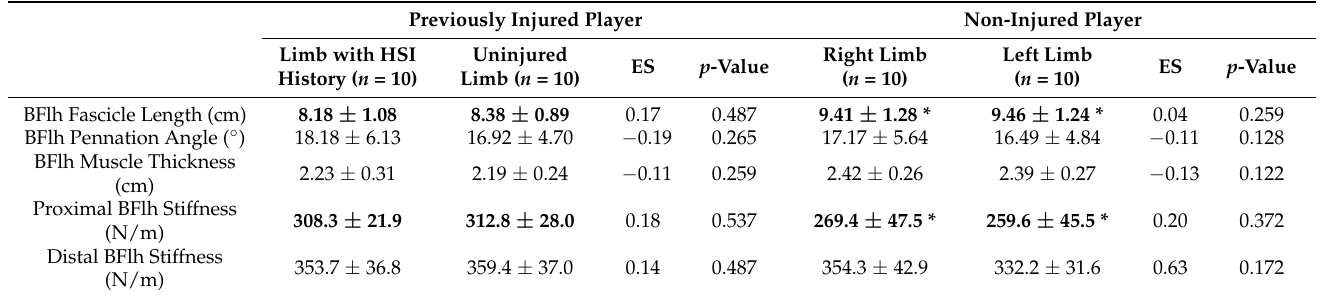
Table 1. Comparative muscle architecture and passive stiffness data between limbs of previously injured players and non-injured players. Data are presented as mean ±